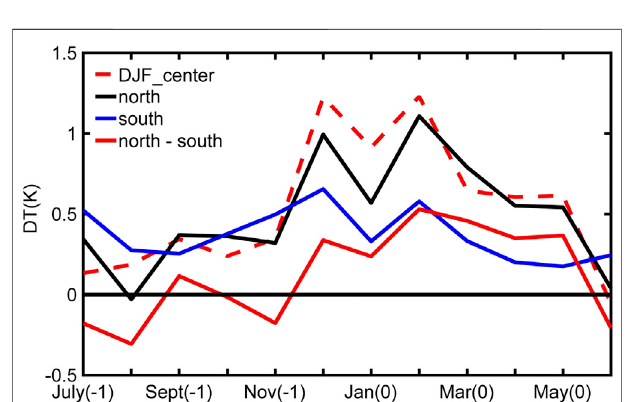
FIGURE 6 | Monthly evolution of the area-averaged 500 – 200 hPa temperature differences (K) between two epochs over the domain (DJF_center, 25 ° – 32.5 ° N, 100 ° – 120 ° E, red dashed line), the northern part (north, 20 ° – 25 ° N, 105 ° – 120 ° E, black solid line) and the southern part (south, 2.5 ° S – 2.5 ° N, 105 ° – 120 ° E, blue solid line) of the SCS monsoon region. The red solid line is epochal difference of the MTG (north – south). Numbers “ − 1 ” and “ 0 ” in brackets on the abscissa denote (1993 – 2016) minus (1979 – 1992) and (1994 – 2017) minus (1980 – 1993), respectively.